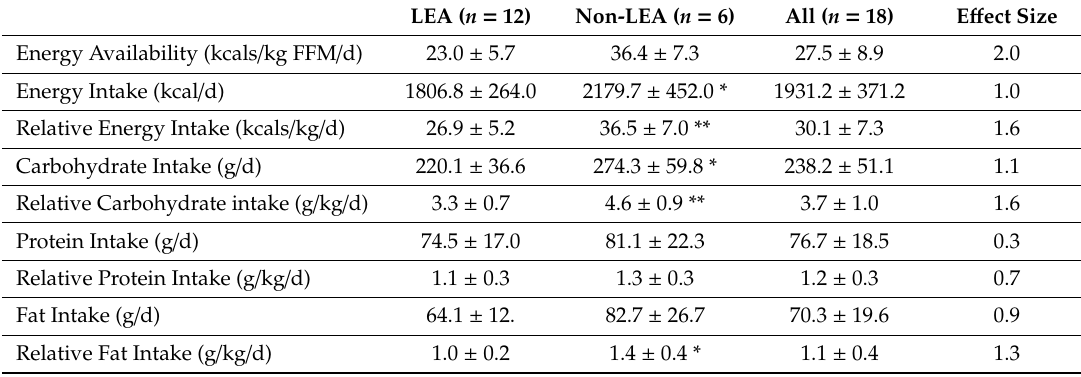
Table 2. A summary of average daily energy and macronutrient intake by energy status.